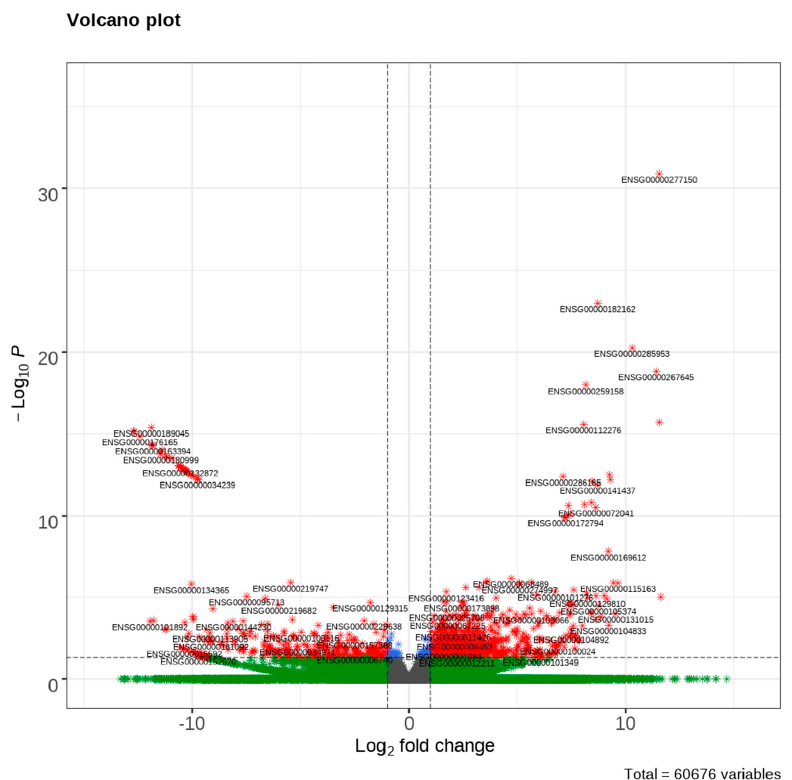
Figure 1. A volcano plot of differentially expressed genes (DEGs) of high tumor budding in cervical cancer. Top 30 up-regulated and top 30 downregulated DEGs are plotted. The upper right corner indicates over-expressed DEGs and upper left corner indicates down-expressed DEGs.